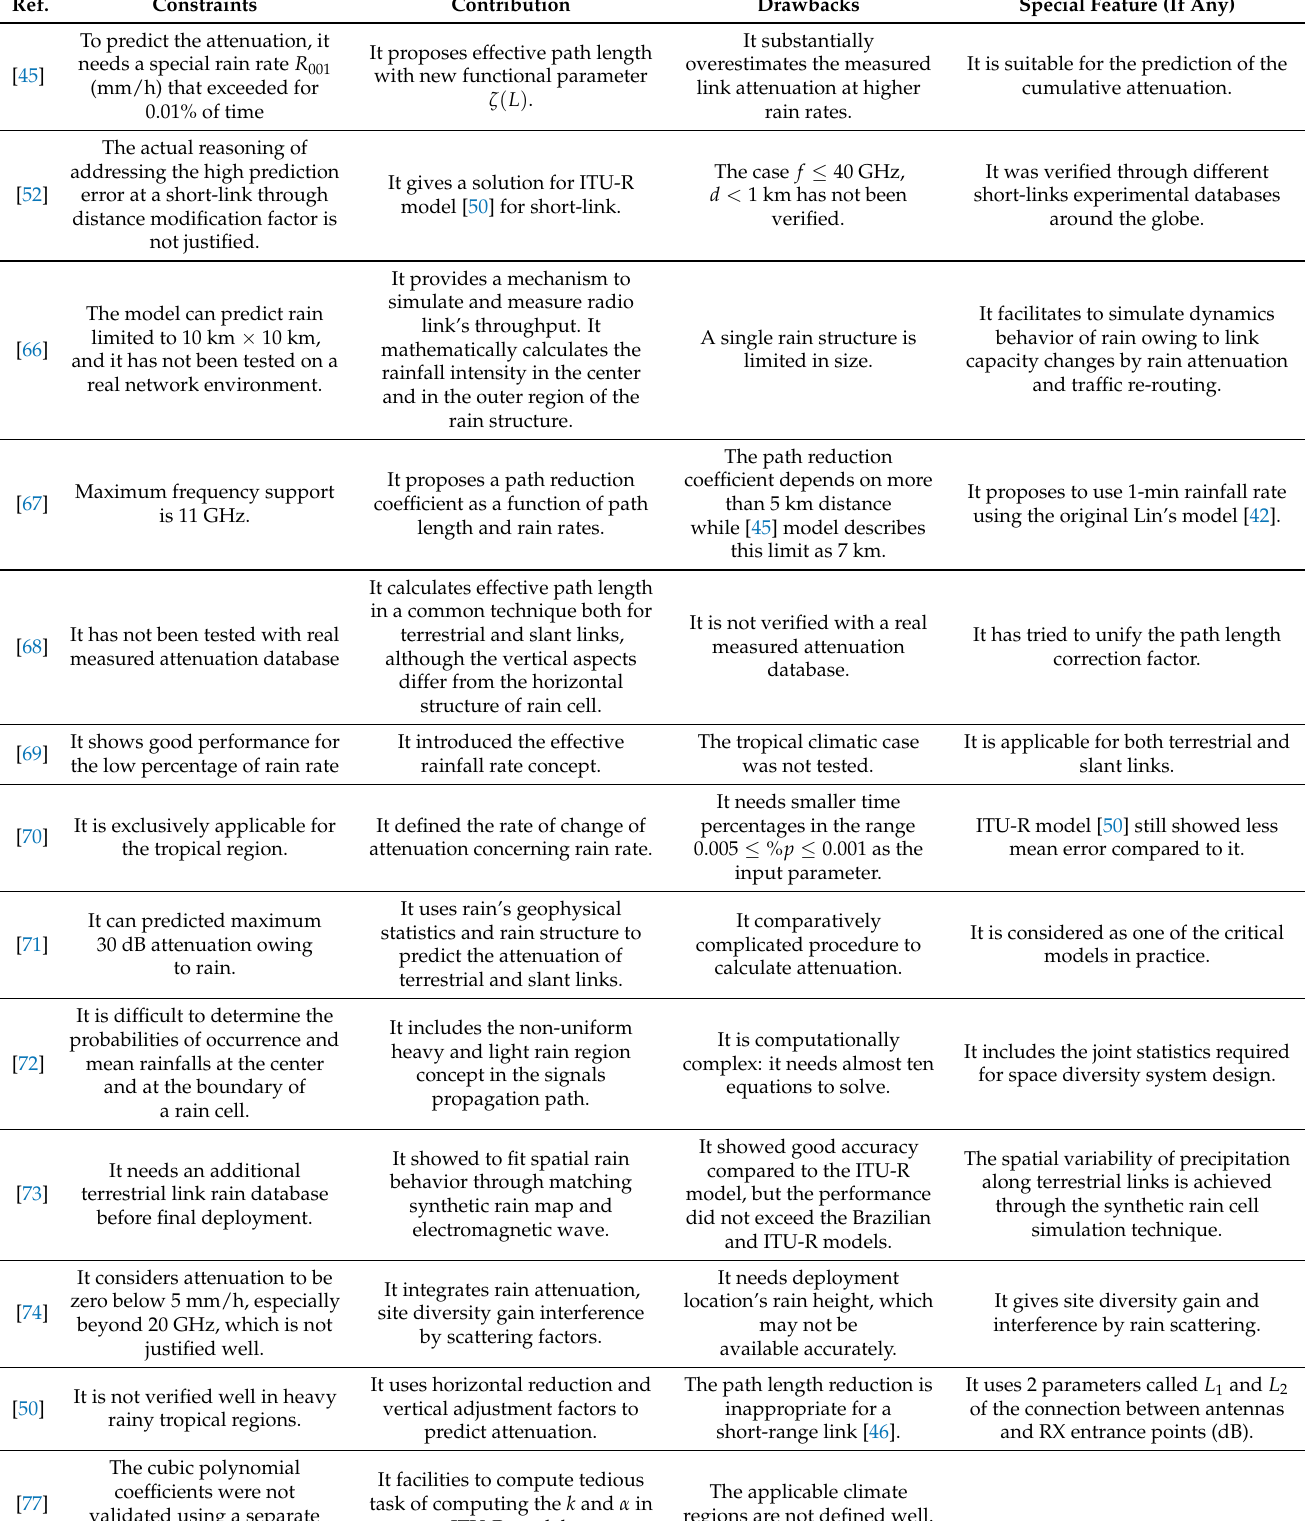
Table 8. Terrestrial rain attenuation models’ constraints, major contribution, drawbacks, and special feature (if there exists). Ref. Constraints Contribution Drawbacks Special Feature (If